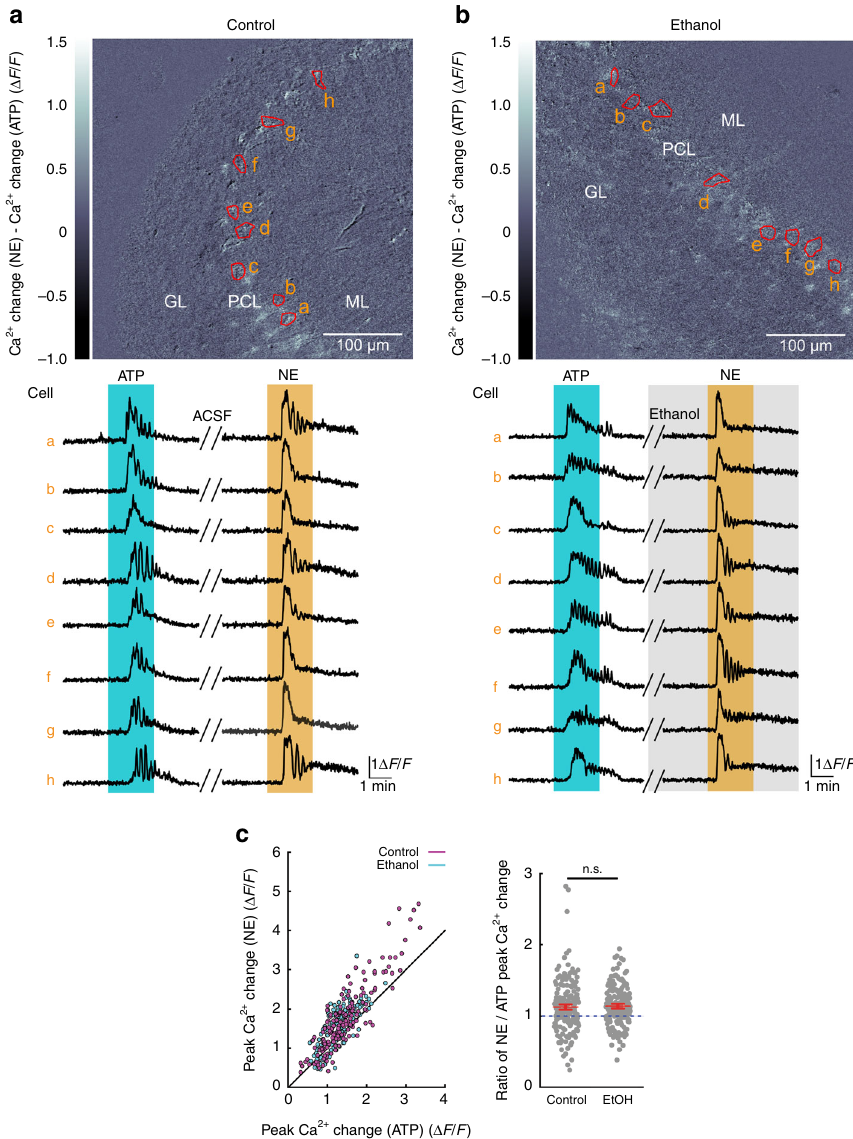
Fig. 5 Ethanol does not impair the responsiveness of BG to NE. a Upper, Visualization of the difference between responses to ATP (100 μ M) and NE (30 μ M) of BG in acute cerebellar slices from 4-week-old Aldh1l1-CreER T2 ;Ai95 mice. Red circumferences indicate ROIs enclosing representative BG somata in the PCL. Lower, Ca 2 + change traces for each ROI. Double-line blanks 11 min of washout with aCSF. Nine independent experimental repetitions were obtained with similar results. b Same as in a ; however, NE was bath applied in the presence of ethanol (30 mM). Ten independent experimental repetitions were obtained with similar results. c Left, Population data: Comparison of peak Ca 2 + change in individual BG in response to NE or ATP. Diagonal illustrates equi-response line. Right, Ratio of Ca 2 + responses of individual BG to NE/ATP. Red symbols indicate mean ± SEM. Control, n = 174 BG from nine slices and three mice; ethanol, n = 170 BG from 10 slices and 3 mice; unpaired, two-tailed Student ’ s t -test ( t (342) = − 0.222; n.s. not signi fi cant). EtOH ethanol. Source data are provided as a Source Data fi potentials reaching the terminals, rather than to a complete abolition of action potentials.